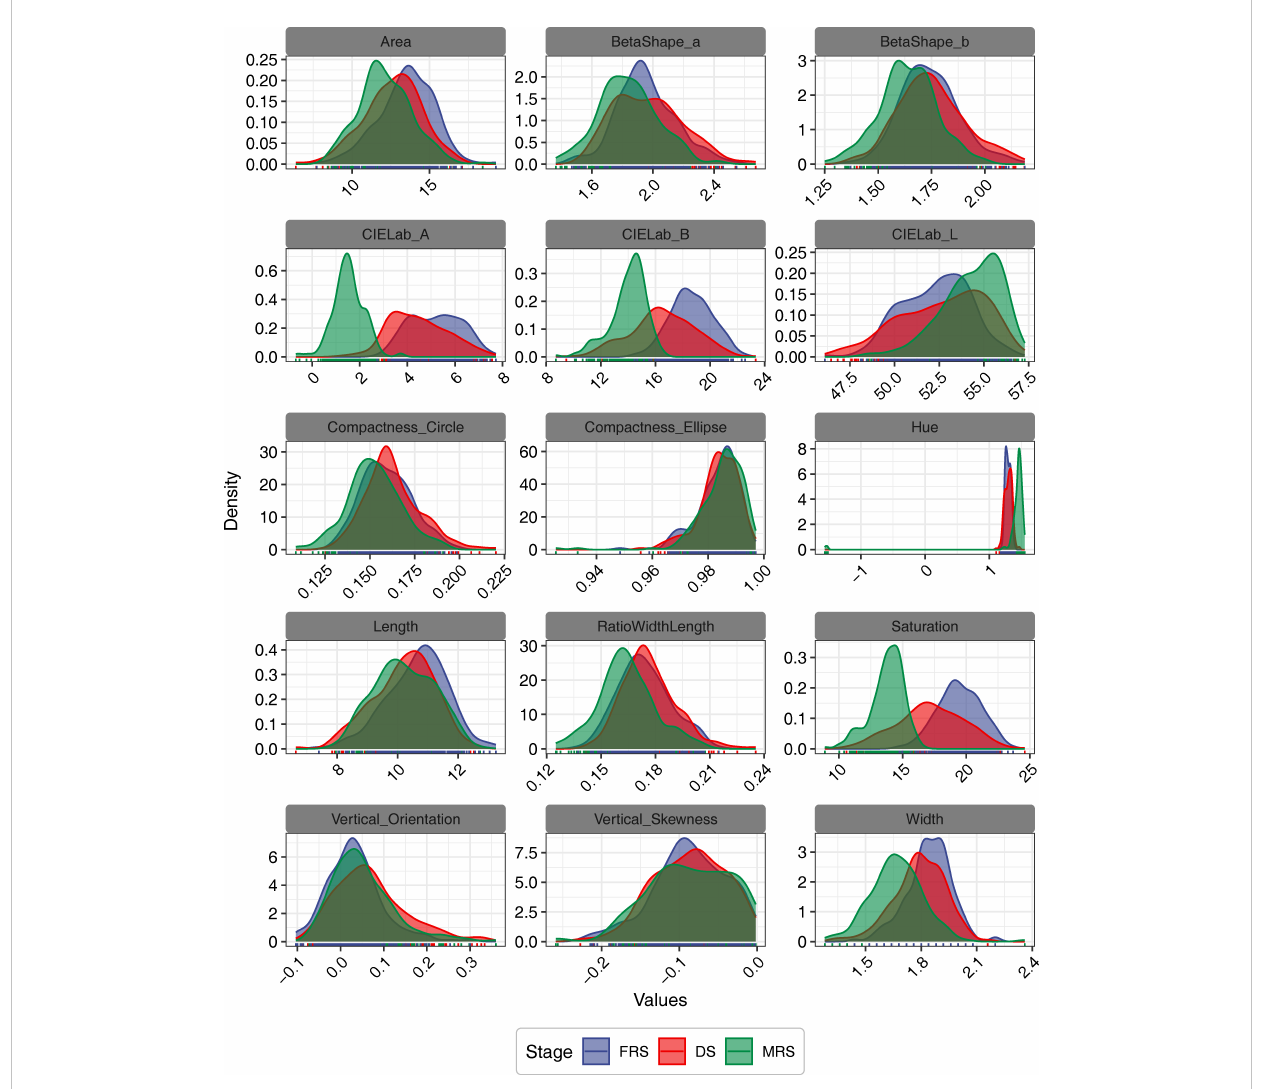
FIGURE 3 The probability density distributions of morphological features of Siberian wild rye seeds for different stages and grain